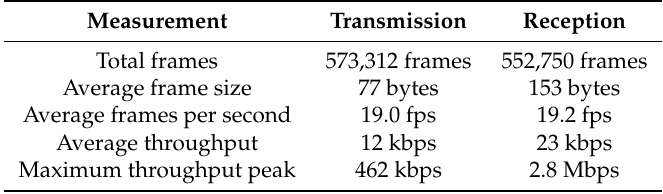
Table 1. Results of running an idle IPFS node for 8